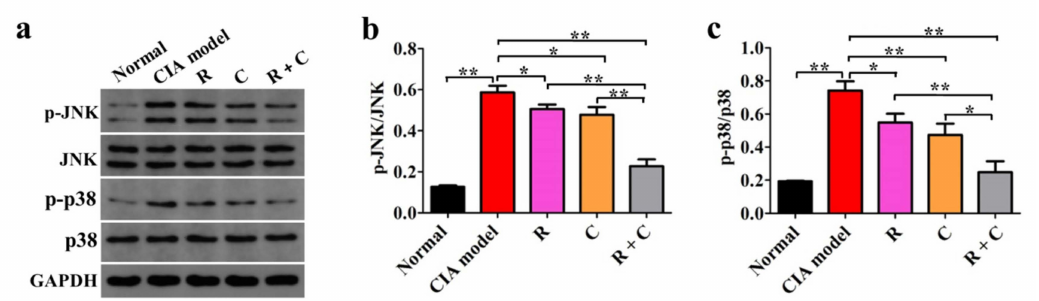
Figure 7. Rosmanol (R), carnosol (C), and their combination (R + C) inhibited the JNK and p38 MAPK pathways. The protein expression levels of JNK, p-JNK, p38, and p-p38 in synovial tissue samples of each group were examined by Western blot on day 42 ( a ) and the relative phosphorylation rates of JNK ( b ) and p38 ( c ) were calculated. GAPDH was used as the internal reference to quantify the expression levels of JNK, p-JNK, p38, and p-p38. The phosphorylation rates of JNK and p38 were expressed as p-JNK/JNK and p-p38/p38, respectively. Data are presented as the means ± SD ( n = 3). The significance of differences was analyzed by unpaired t -test. Note: * p < 0.05; ** p <